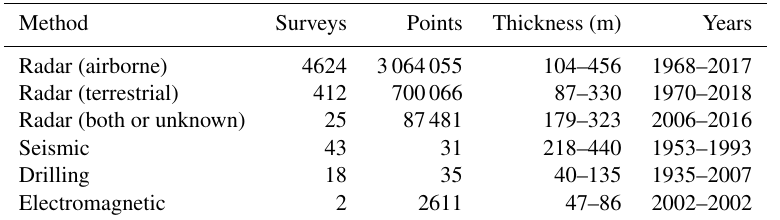
Table 1. Number of glacier surveys and point measurements, interquartile range of point thicknesses, and full range of survey years by survey method. In the database, a “survey” roughly represents one measurement campaign on one glacier, and a “point” represents a single ice thickness measurement (as opposed to a spatial mean).